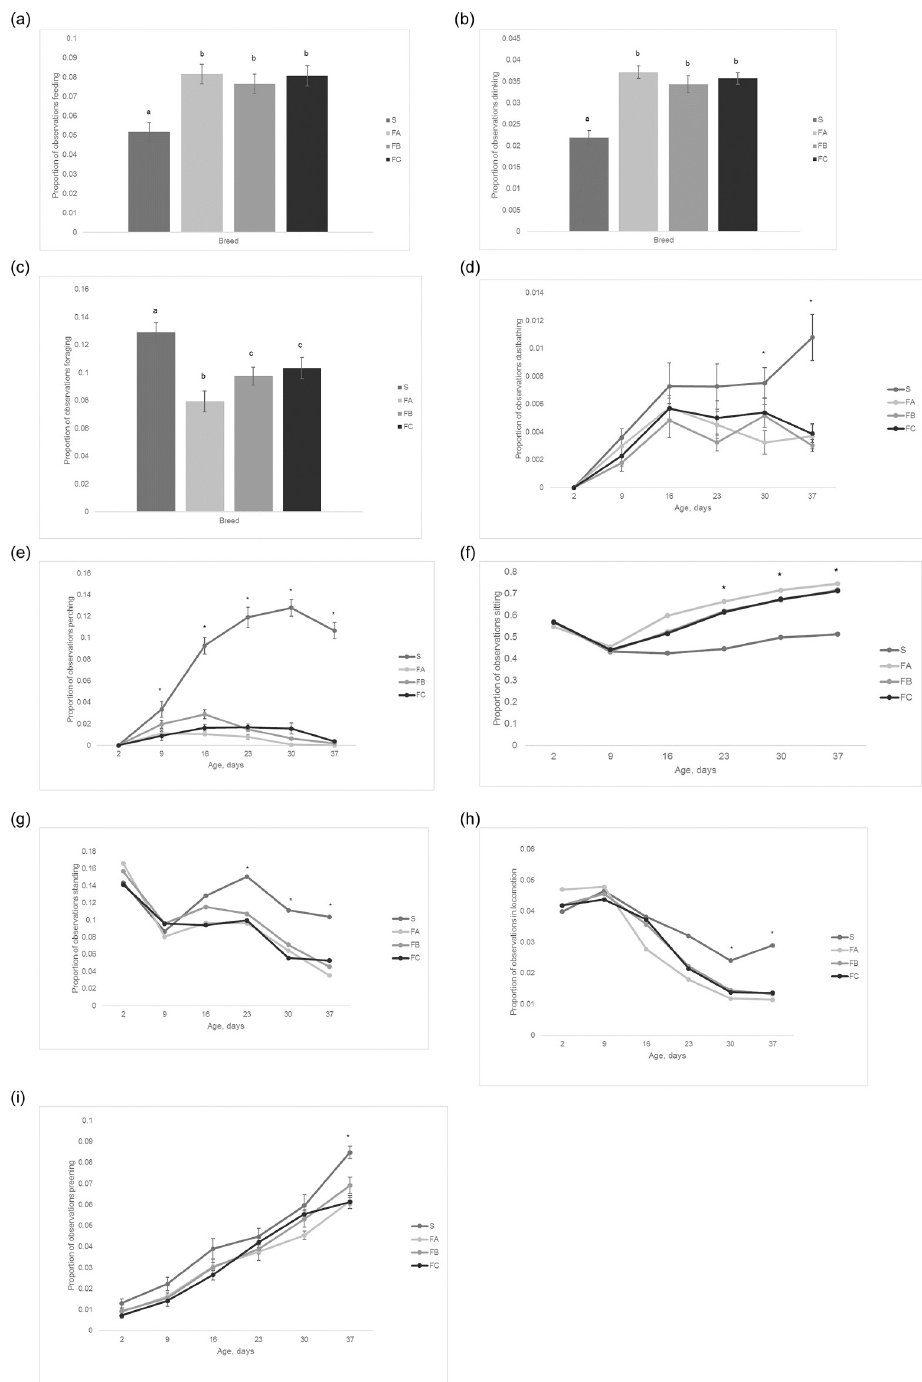
Fig 7. The mean proportions of time spent a) feeding ( ± SEM), b) drinking ( ± SEM), c) foraging ( ± SEM), d) dustbathing ( ± SEM), e) perching ( ± SEM), f) sitting (back transformed), g) standing (back transformed), h) in locomotion (back transformed), and i) preening ( ± SEM) during the lights on period for the four breeds. Different letters and asterik symbols denote signicant differences.